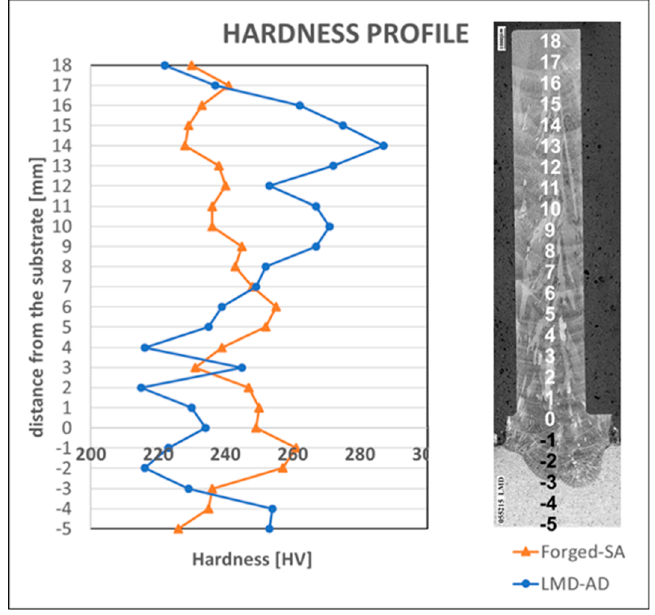
Figure 8. Hardness profiles of the walls.